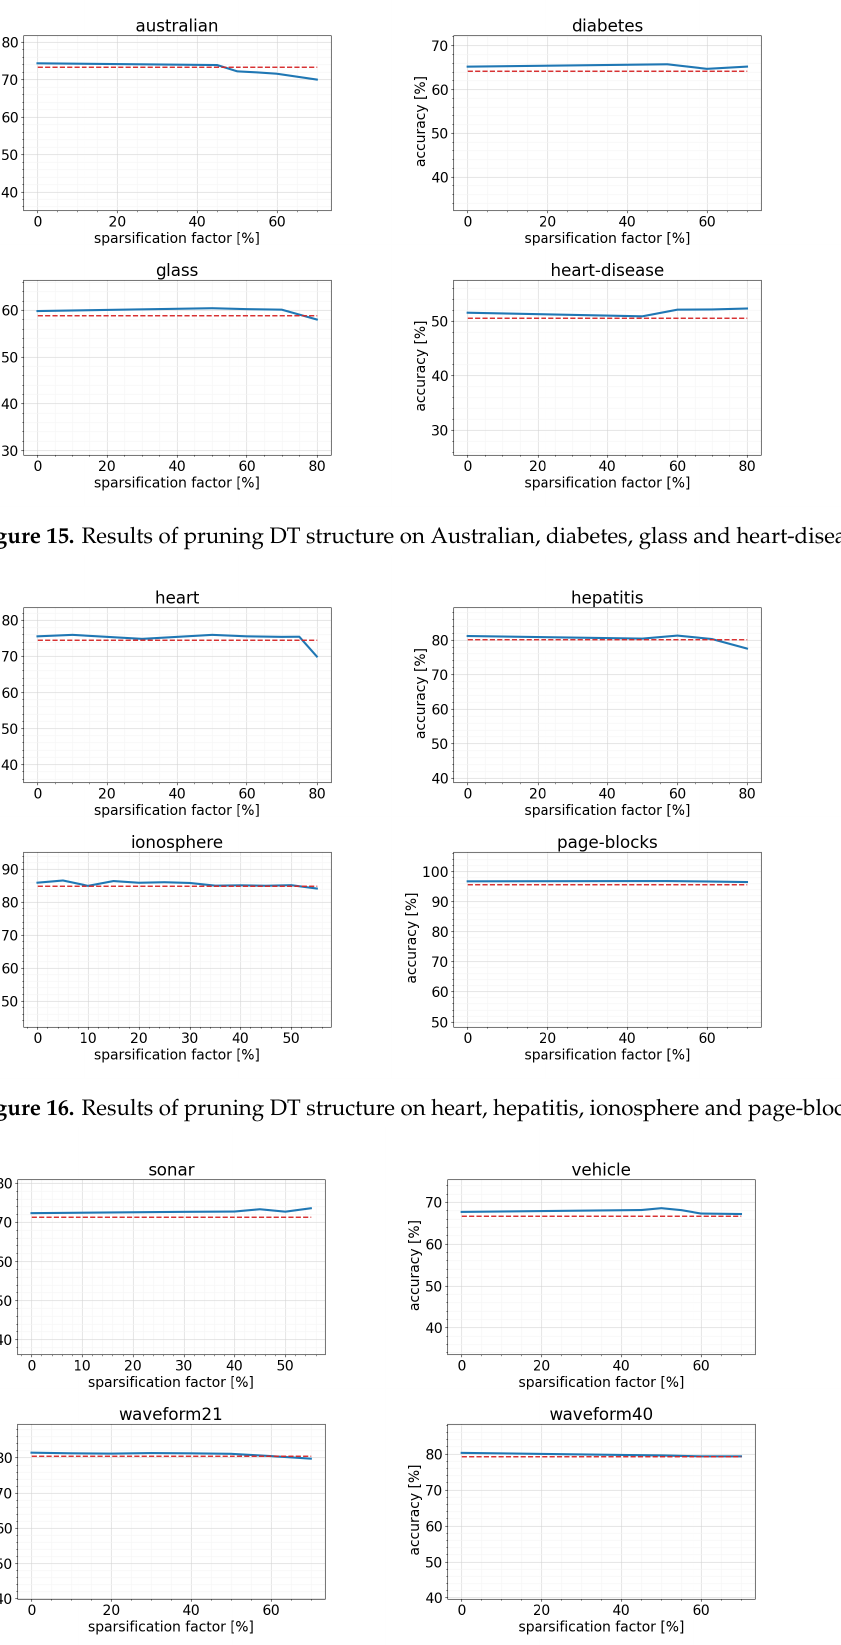
Figure 17. Results of pruning DT structure on sonar, vehicle, waveform21 and waveform40